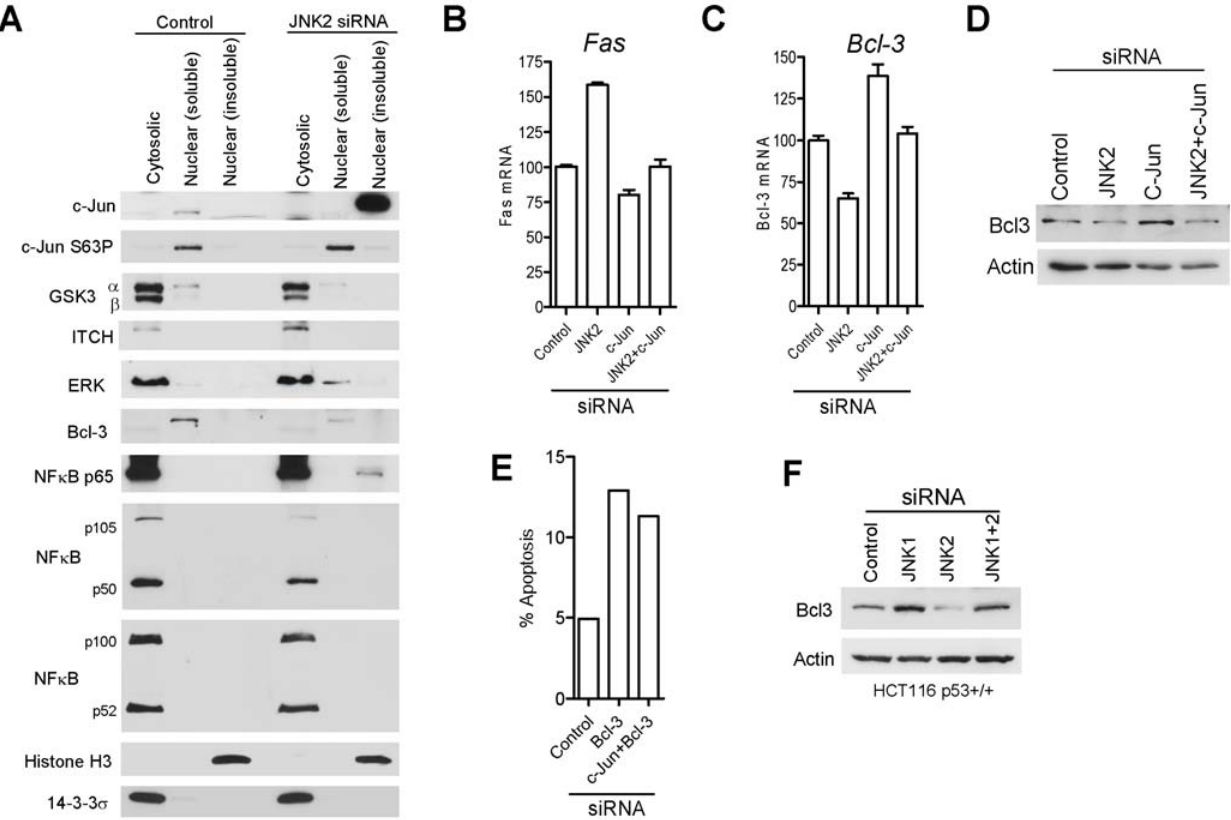
Figure 8. Non-phosphorylated c-Jun accumulates in the insoluble nuclear fraction following JNK2 silencing and down-regulates Bcl-3 expression in HCT116 p53 + / + cells. (A) Nuclear and cytoplasmic preparations following control and JNK2 siRNA treatment. Immunoblots show protein levels in the fractions indicated, equivalent cell number per lane. Histone H3 (nuclear insoluble) and 14-3-3 s (cytoplasmic) fractionation controls. (B and C) Quantitative PCR analysis of Fas and Bcl-3 mRNA. (D) Bcl-3 protein levels following siRNA treatment. (E) Levels of apoptosis following Bcl-3 or combined Bcl-3 and c-Jun siRNA treatment. (F) Immunoblots showing levels of Bcl-3 following siRNA treatment.